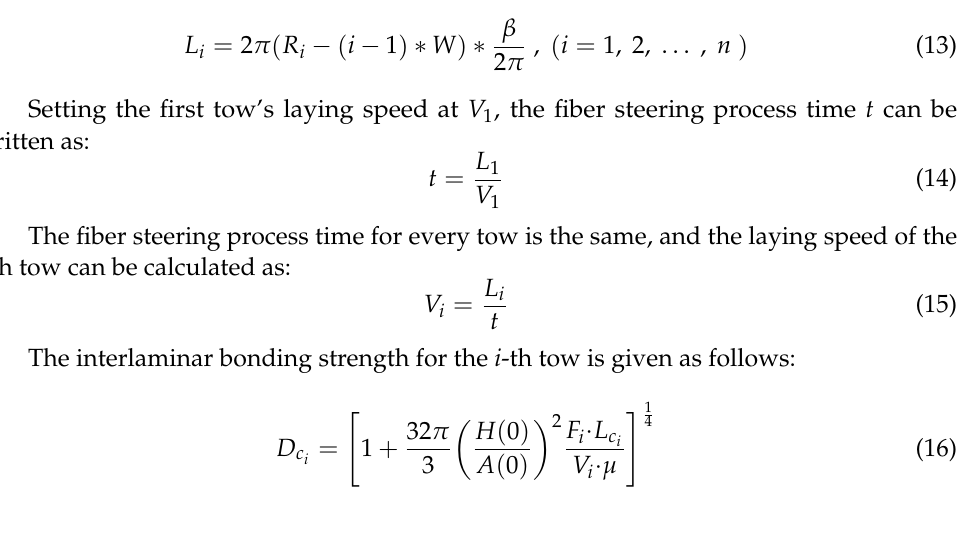
Figure 6. The path of laying the circle.